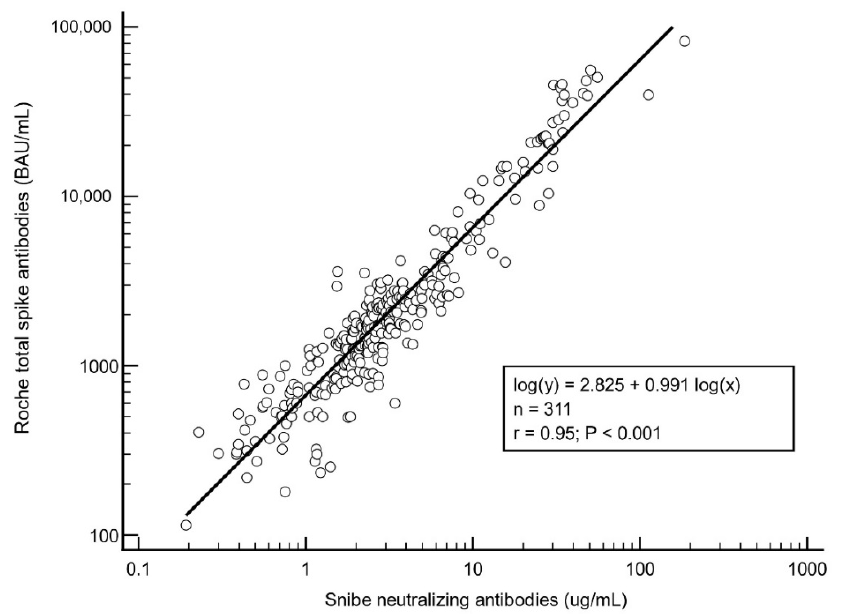
Figure 2. Regression analysis between total spike and neutralizing antibodies after second and third vaccinations. Data used in this figure includes data from this study (current post-booster population) and from our previous study (prior post-second dose population) [12] and are thus different individuals.